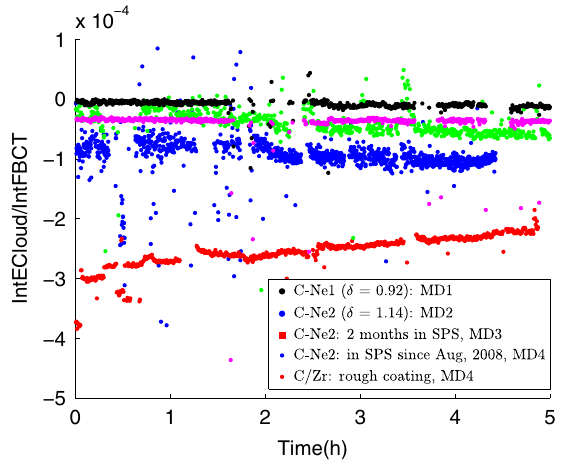
FIG. 5. Normalized e-cloud signals on different a-C coatings from the MD runs. The e-cloud has a magnitude of 10 (cid:2) 4 . Integrated electron current signal (negative values) for each supercycle divided by integrated FBCT signal for each super- cycle [ nC = 10 10 protons per bunch] as a function of supercycle number.